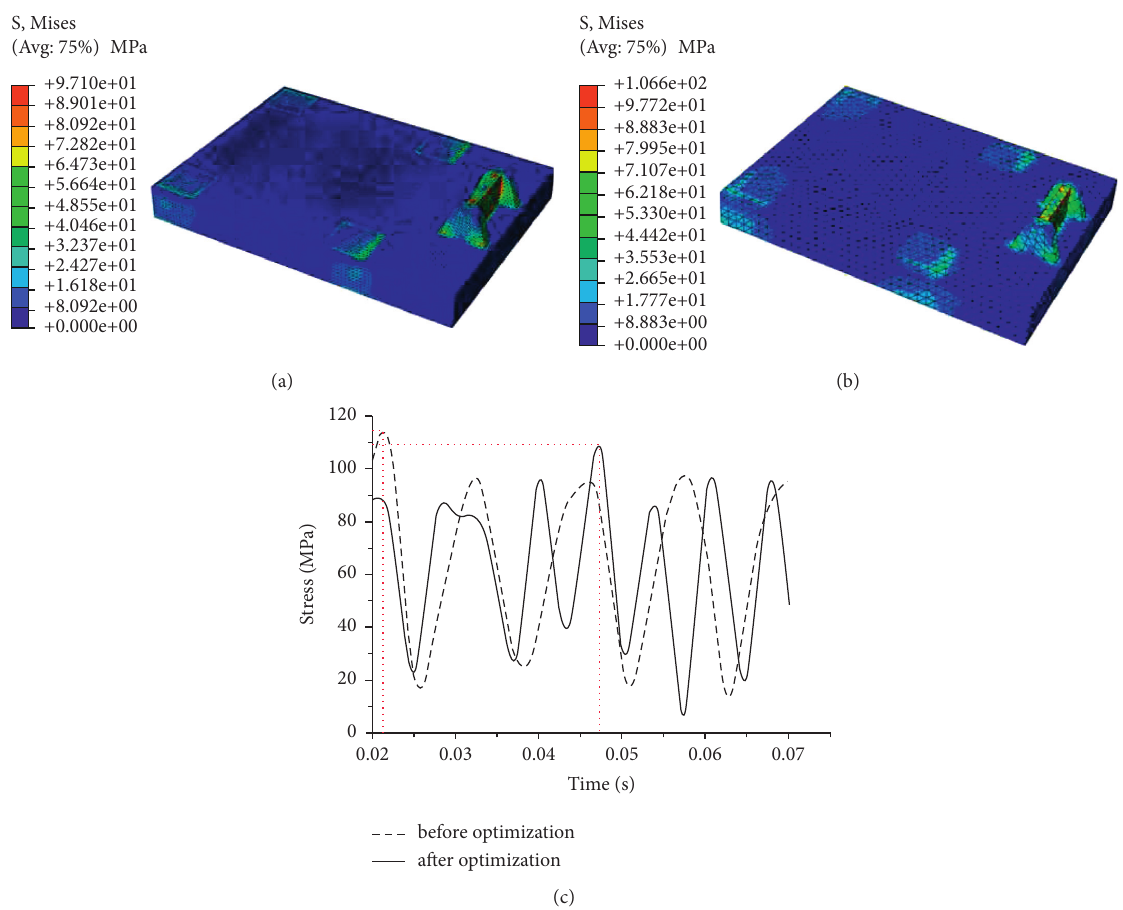
Figure 13: Stress cloud diagram and curve of the front and rear base of the frame after sudden unloading before and after optimization. (a) Stress cloud diagram of the base before optimization. (b) Stress cloud diagram of the base after optimization. (c) Stress curve of the base before and after